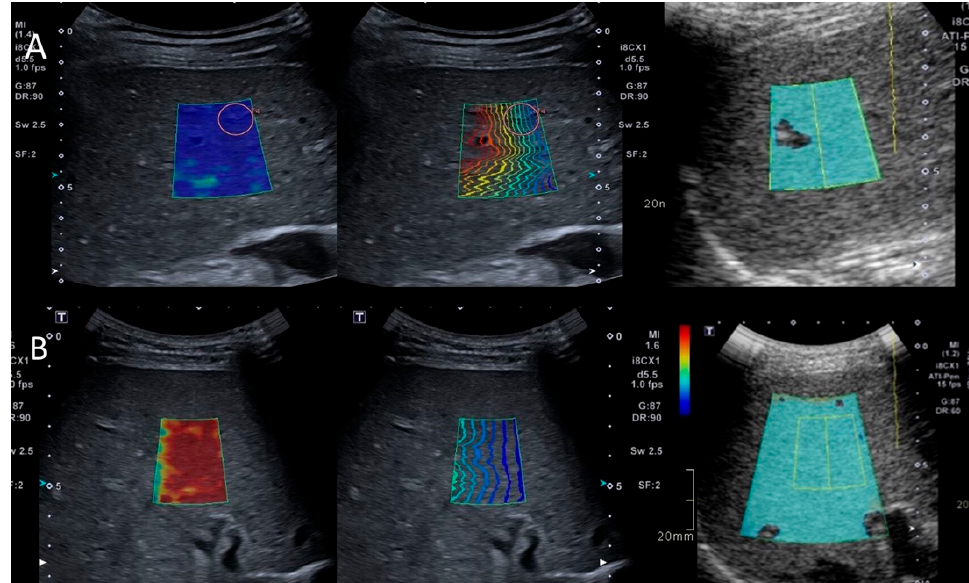
Figure 2. ( A ): An 11-year-old child with ulcerous colitis and autoimmune hepatitis under treatment. The colormap and SWE (left/middle) display homogeneous color and normal propagation of the shear waves with all markers low: SWE 3.9 kPa, SWD 10.5 m/s/kHz and ATI 0.57 0.53 db/cm/MHz. The biopsy showed no signs of fibrosis, inflammation or steatosis. ( B ): Previously healthy 15-year-old child with increased AST/ALT. SWE (left) displays intense red, inhomogeneous color with increased distance between the shear waves (middle). Both SWE (39 kPa) and SWD (middle) 21 (m/s/kHz) values were high. ATI (right) was low (0.53 db/cm/MHz). Biopsy revealed grade 2 fibrosis and inflammation, but no steatosis.